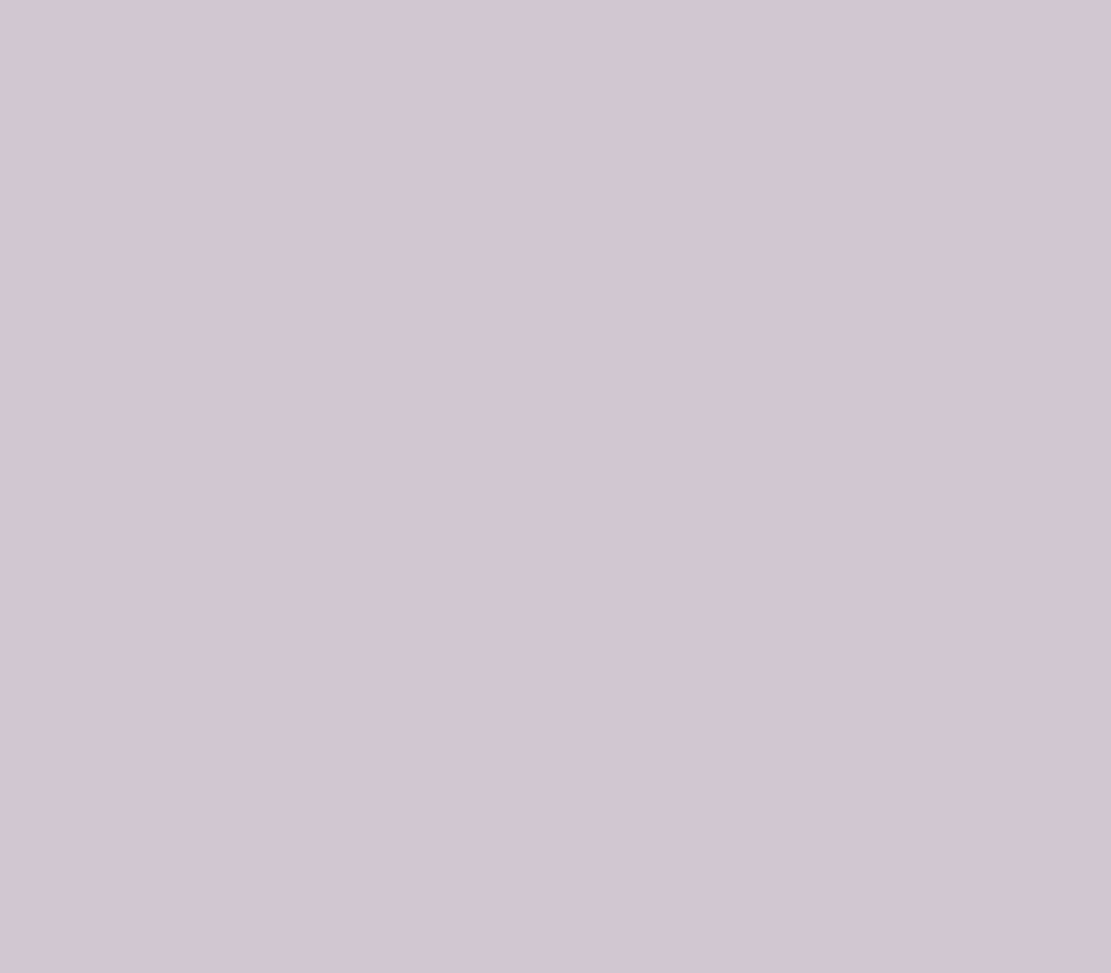
Cervical Cancer Awareness Measure Toolkit Version 2.1 Updated